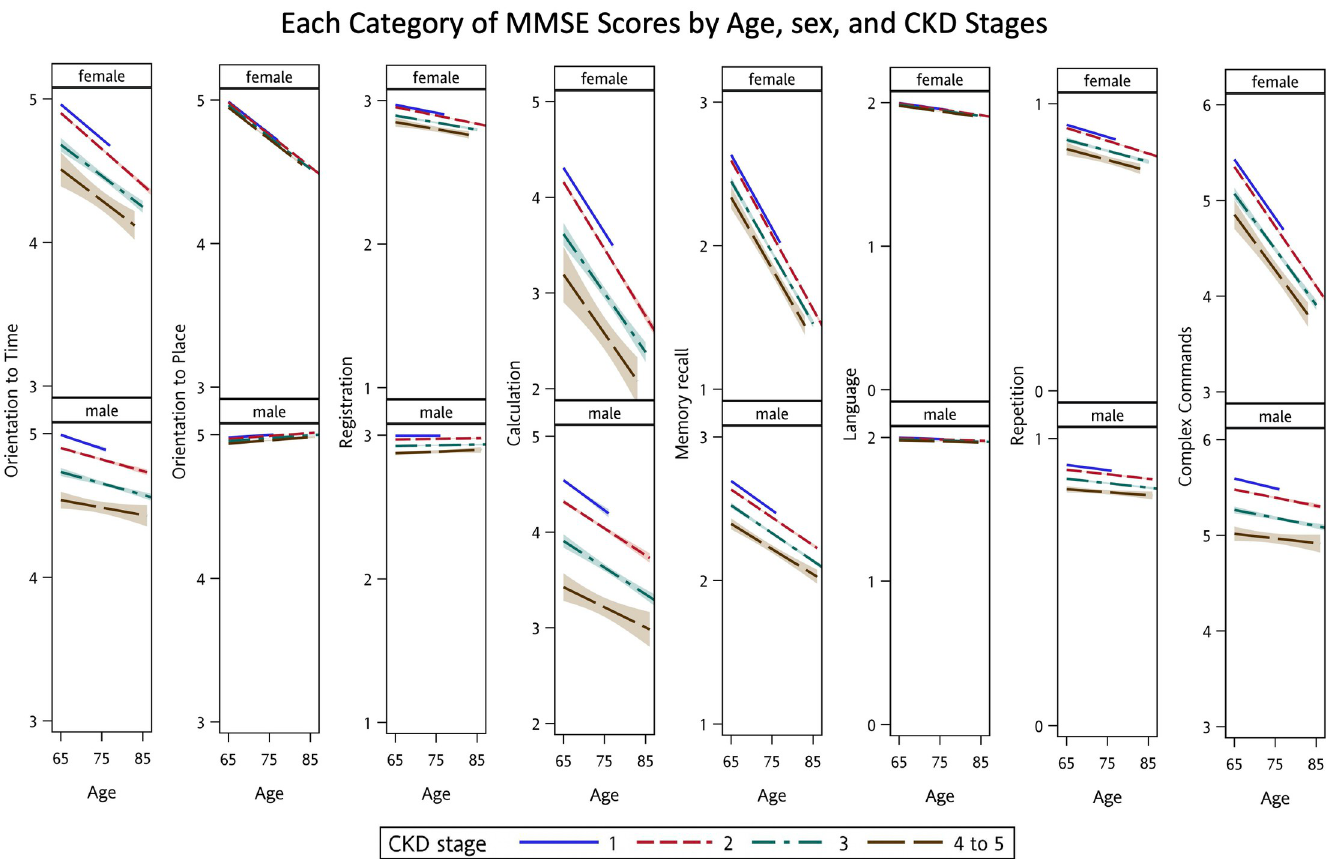
Fig 2. Each category of Mini-Mental State Examination (MMSE) score by age, sex, and chronic kidney disease (CKD) stages.